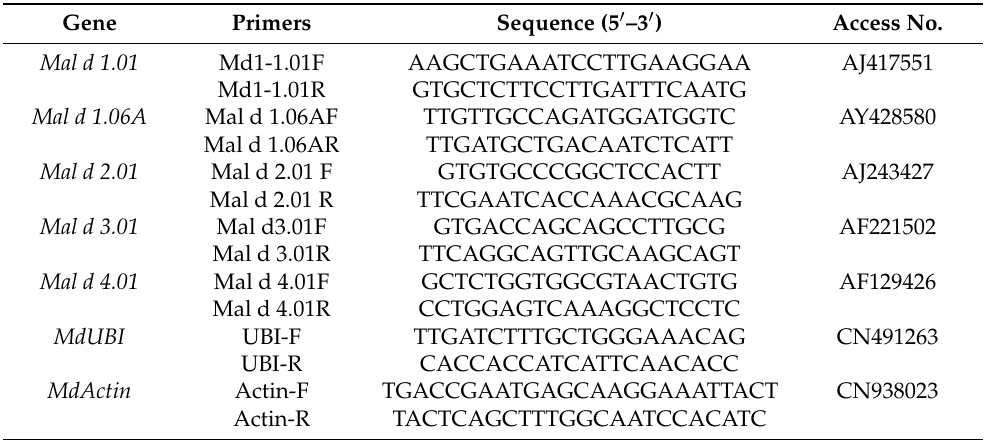
Table 6. Real-time PCR primers